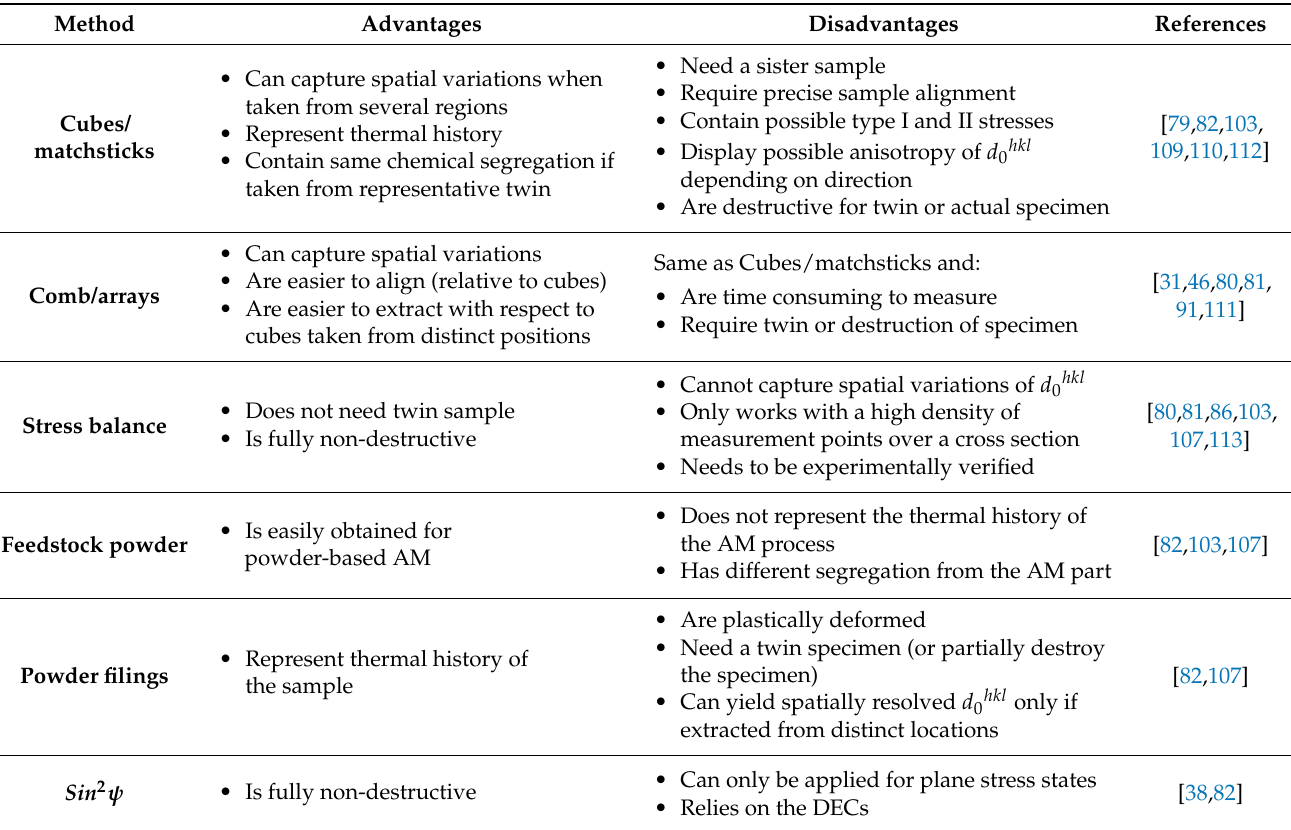
Table 1. Overview of the different methods to obtain a d 0 hkl in the domain of laser-based AM. Method